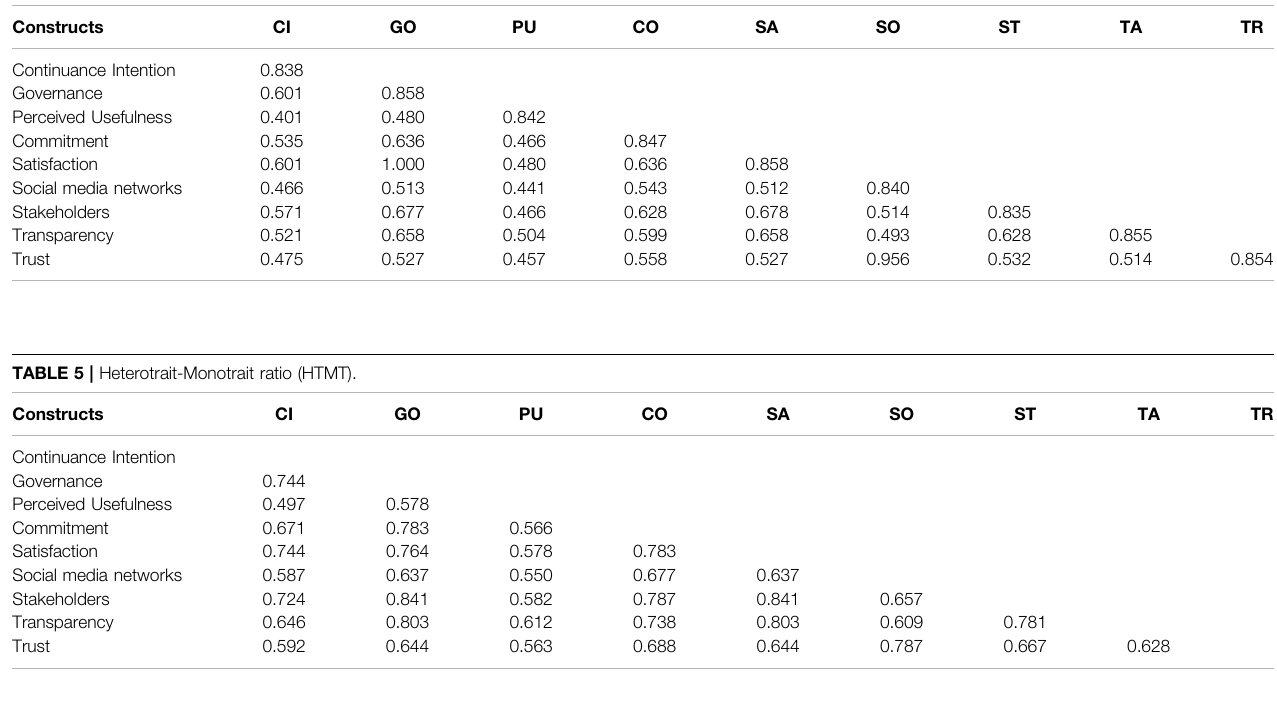
TABLE 4 | Fornell-Larcker criterion.